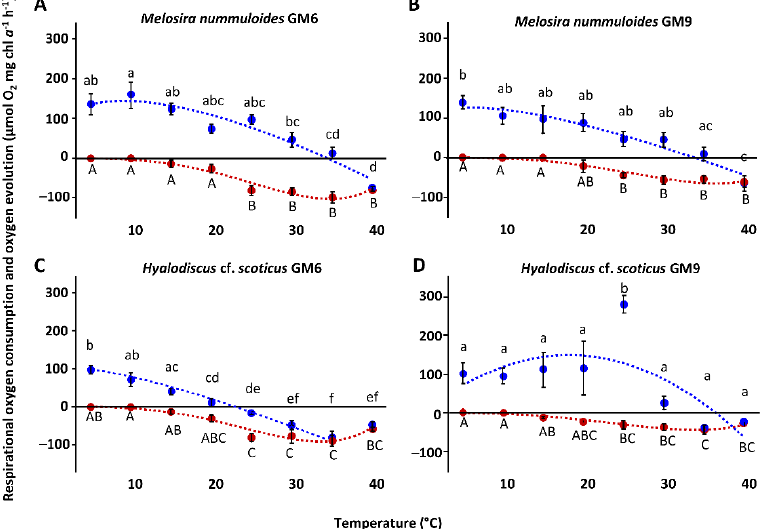
Figure 5. Photosynthetic (blue) oxygen production at 303.4 ± 11 µmol photons m –2 s –1 and respiratory (red) oxygen consumption in darkness of two Baltic Sea benthic diatom strains as a function of increasing temperature. The measured data were fitted by the model of Yan and Hunt [37] (photosyn- thesis: blue dashed line ( C ), 40 °C excluded); respiration: red dashed line). Cultures were kept in GM6 media ( A , C ) and GM9 media ( B , D ). Data represent mean values ± standard deviation (n = 3). Different lowercase (photosynthesis) and capital letters (respiration) indicate significant means ( p < 0.05, one-way ANOVA with post hoc Tukey’s test). ( A ) Melosira nummuloides GM6, ( B ) Melosira nummuloides GM9, ( C ) Hyalodiscus cf. scoticus GM6, and ( D ) Hyalodiscus cf. scoticu s GM9.